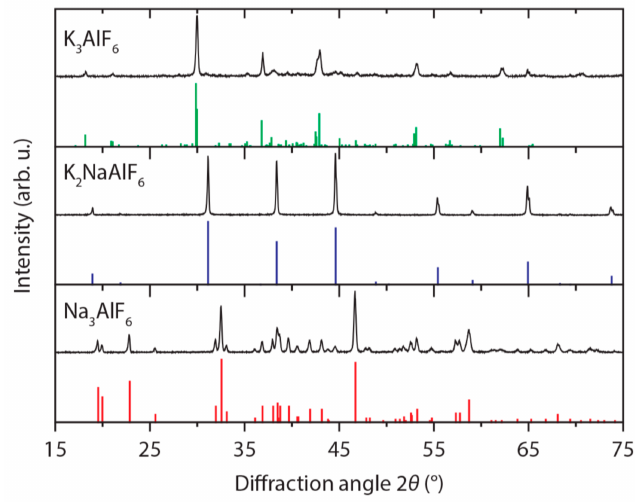
Figure 1. Powder X-ray diffraction (XRD) patterns of M 3 AlF 6 :Mn 4+ (M = Na, K). The XRD patterns of the synthesized phosphors are in excellent agreement with the reference patterns for Na 3 AlF 6 (PDF 00-025-0772, red), K 2 NaAlF 6 (PDF 01-072-2434, blue) and K 3 AlF 6 (PDF 00-057-0227,